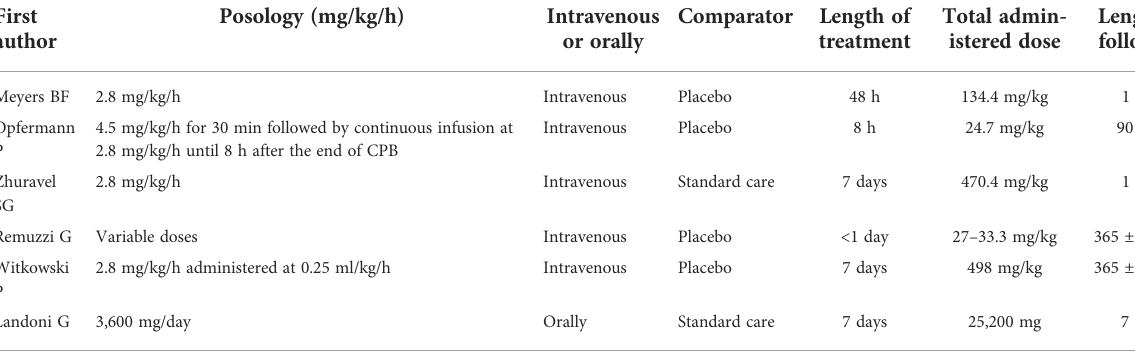
TABLE 2 Doses and modalities of administration of reparixin in the eight included randomized studies.